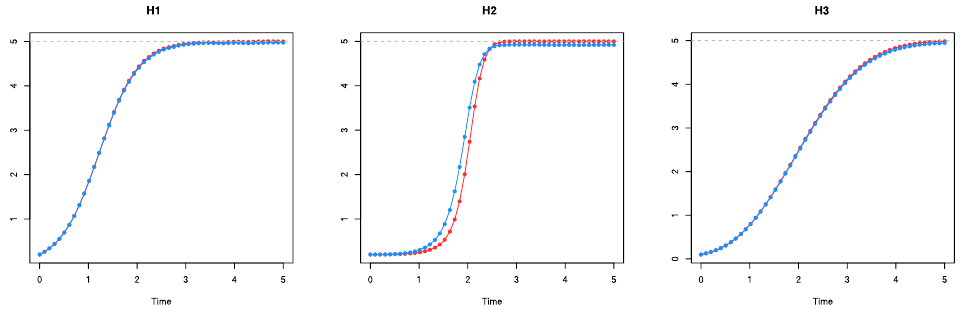
Figure 1. For every model, comparison of sample mean of simulated paths for the original stochastic version (red) and the lognormal version